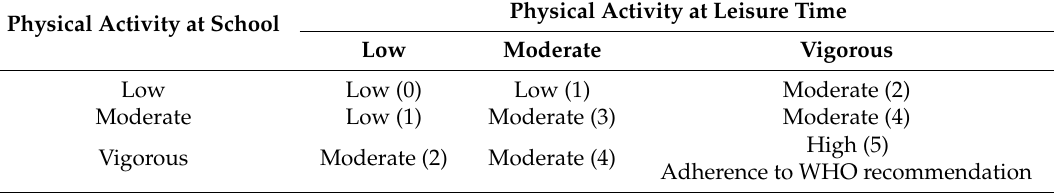
Table 5. Categorizing and scoring (points) of total physical activity based on physical activity at school and leisure time.